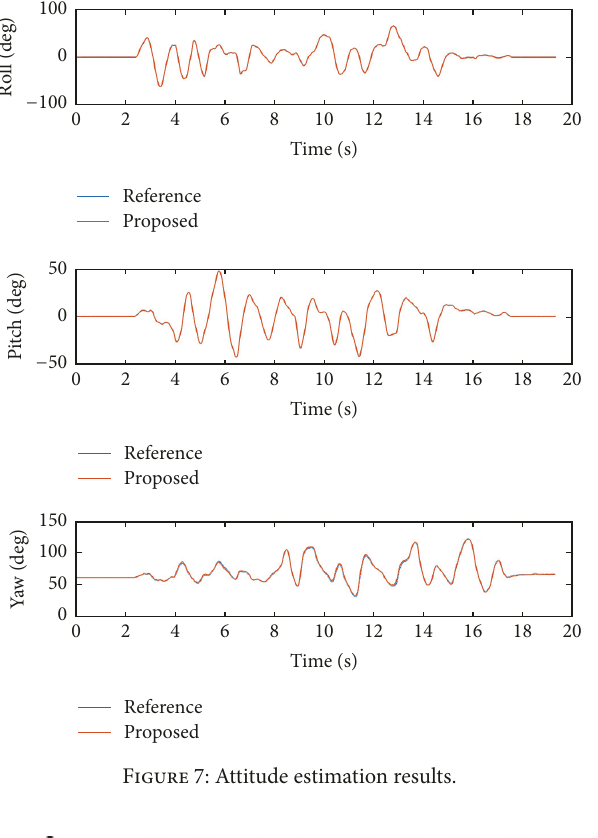
Figure 7: Attitude estimation results.